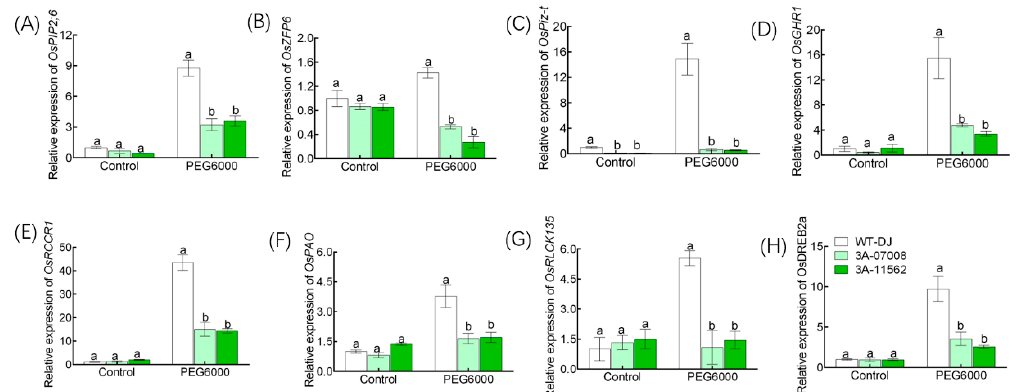
Figure 9. Verification for expressions of eight selected DEGs. Relative expression of the genes in the leaf of ostbp2.2 and WT-DJ were tested by qRT-PCR after PEG treatment. The tested genes include OsPIP2;6 ( A ), OsZFP6 ( B ), OsPiz-t ( C ), OsGHR1 ( D ), OsRCCR1 ( E ), OsPAO ( F ), OsRLCK135 ( G ), and OsDREB2a (H). Control, the seedlings were grown in normal IRRI solution; PEG6000, the seedlings were grown in normal IRRI solution with 15% PEG6000. Error bars: SE ( n = 3). Significant differences between ostbp2.2 and WT-DJ are indicated by different letters. ( p < 0.05).